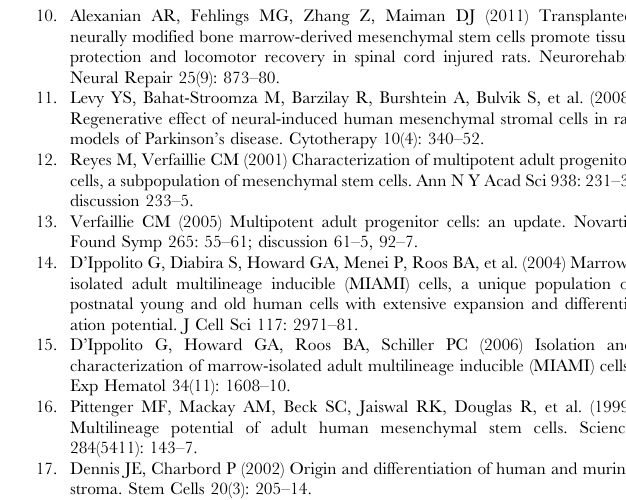
Figure S2 Tyrosine hydroxylase staining of brain-in- jected NCSC mix , at different delays post